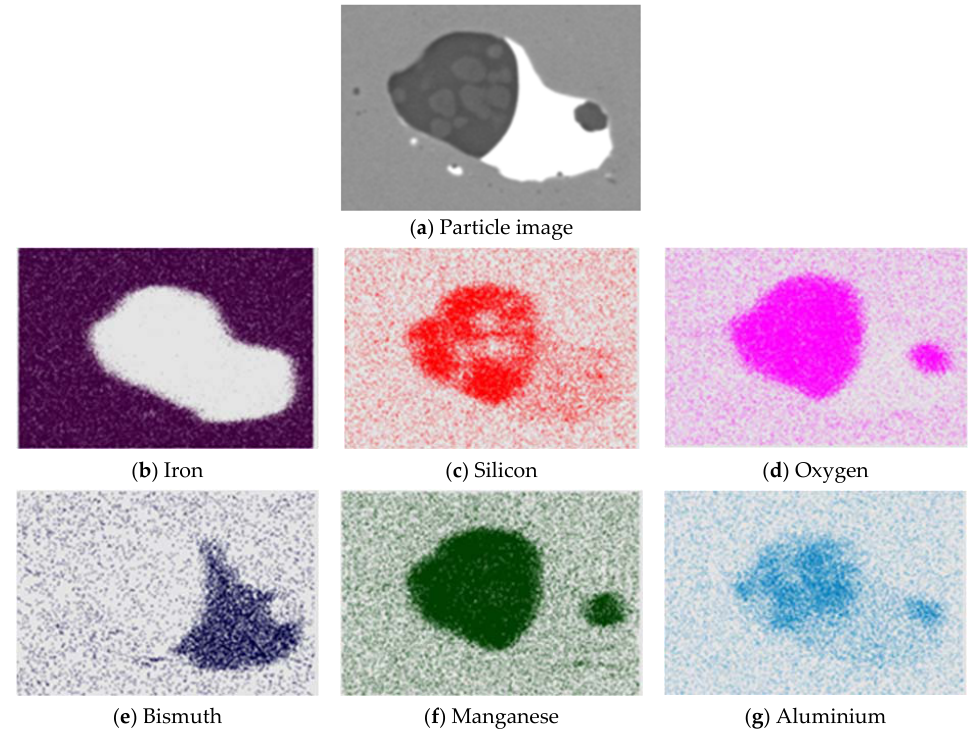
Figure 11. EDS mapping—distribution of individual elements ( b ) Iron, ( c ) Silicon, ( d ) Oxygen, ( e ) Bismuth, ( f ) Manganese, ( g ) Aluminiumin a ( a ) complex particle with Bi in CMnCr steel with 0.08 wt.%